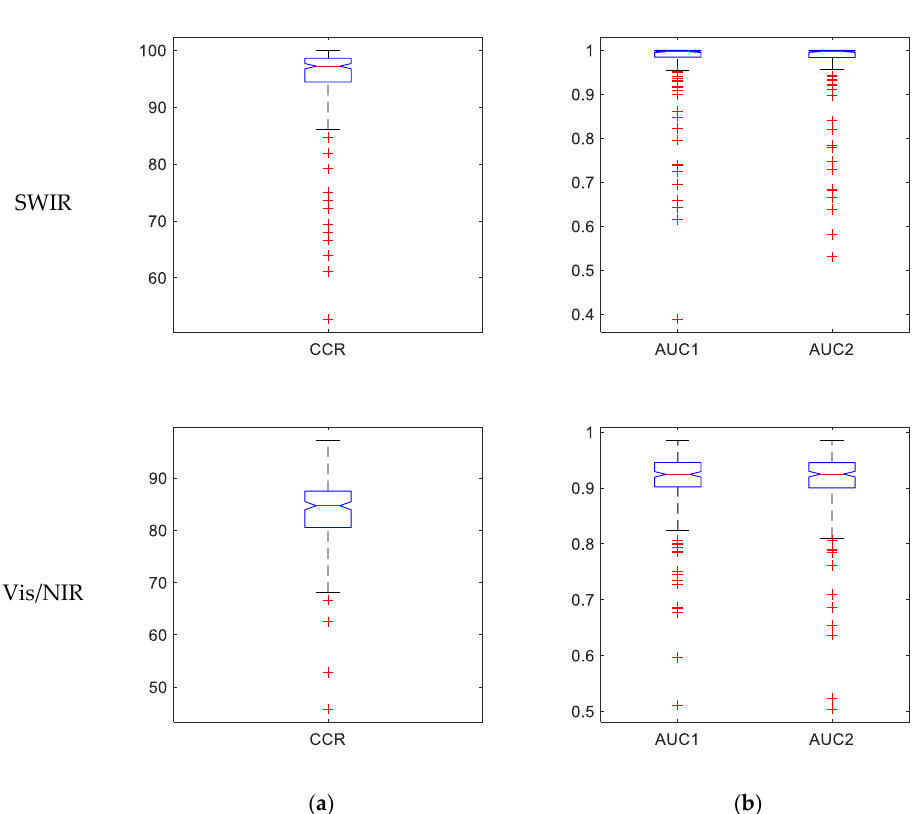
Figure 6. Boxplots of the performance of the MV classifier for potato classification for the 200 repetitions. ( a ) Correct classification rates. ( b ) Areas under the ROC curve (AUC), AUC1 refers to the defective class, and AUC2 to the healthy class. Upper row: classification using SWIR spectral range. Lower row: classification using Vis/NIR spectral range. Figure 7 represents the ROC curve of the ensemble classifier for the 200 iterations. As it is clear, the graphs of both classes are far from the bisector line and closer to the vertical, indicating the high performance of the classifier in the corresponding